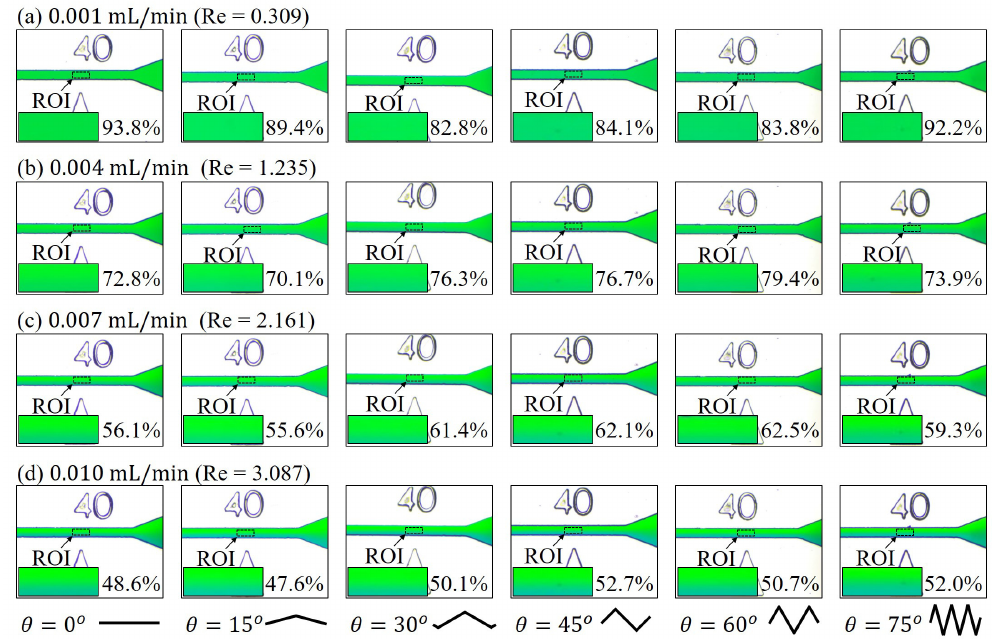
Figure 6. Experimental results of mixing with six different zigzag angles at low flow